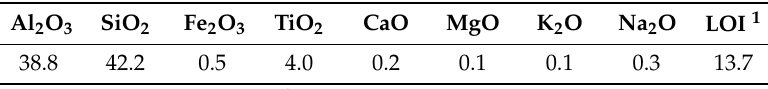
Table 1. Chemical composition of kaolinite raw